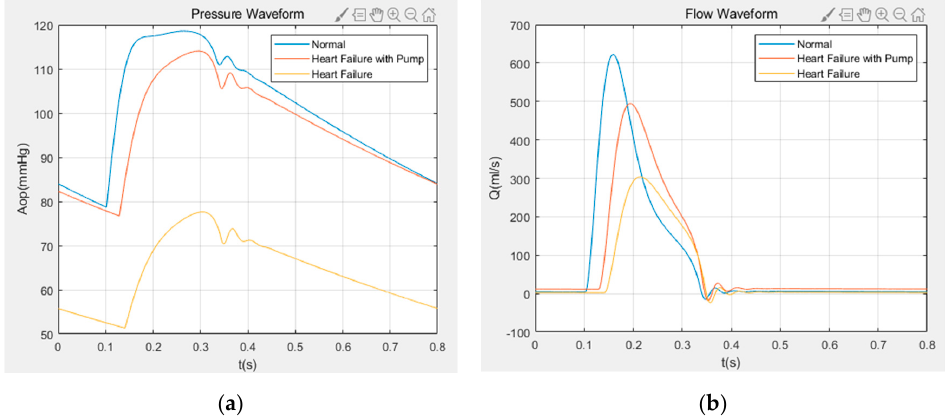
Figure 13. Hemodynamic waveform of heart failure class IV: ( a ) aortic pressure waveform; ( b ) aortic flow waveform.